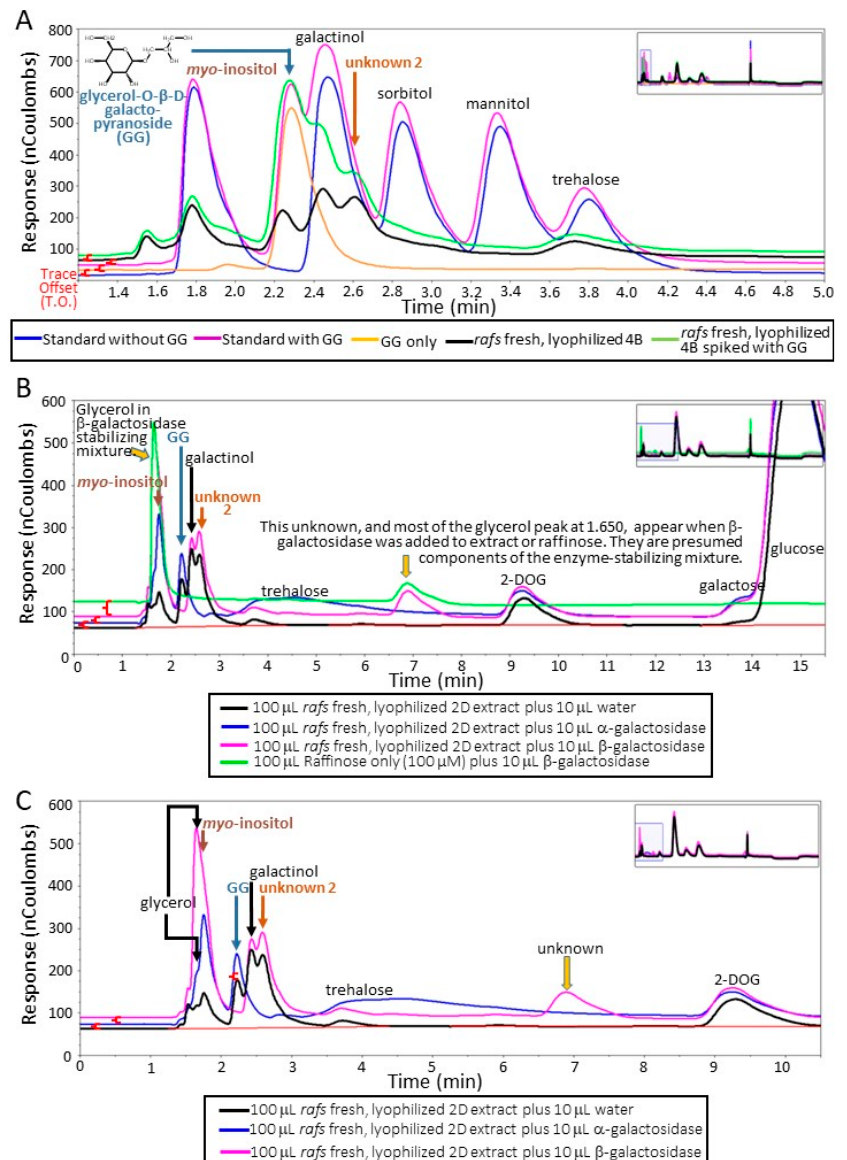
Figure 2. Verification of the identity of unknowns in maize leaf carbohydrate extracts. Glycerol-O- β -D-galactopyranoside (GG; inset on the left: chemical structure) was acquired from a commercial source and run on both the Waters (not shown) and ( A ) the Dionex systems. The overlaid chromatographs show the trace from a 100 µ M GG sample (orange line), 100 µ M GG added to the external standard (pink line) and the external standard without GG (blue line). Additionally, a sample containing large amounts of unknowns 1 and 2 (black line) was spiked with 100 µ M of GG (green line) and run on the Dionex system. ( B ) Chromatographic and enzymatic verification of the tentatively identified GG as unknown 1. Overlays of the unhydrolyzed sample (black line), α - (blue line), or β -galactosidase- hydrolyzed (pink line) aliquots of a sample containing the first and second unknown. A trace of raffinose hydrolyzed with β -galactosidase is also shown (green trace) to emphasize the glycerol increase and the presence of an unknown peak eluting at ~7.0 min is predominantly due to the stabilizers/preservatives in the β -galactosidase preparation. Note the increase in galactose whenever the samples are hydrolyzed. ( C ) A closeup of the overlaid traces in B. In all figures, the trace offset (T.O.) used to overlay chromatographs (red parentheses) is insufficient to explain the peak increases in GG from spiking or enzymatic hydrolysis. This is strong evidence supporting the supposition that hydrolysis of unknown 2 by α -galactosidase produces additional